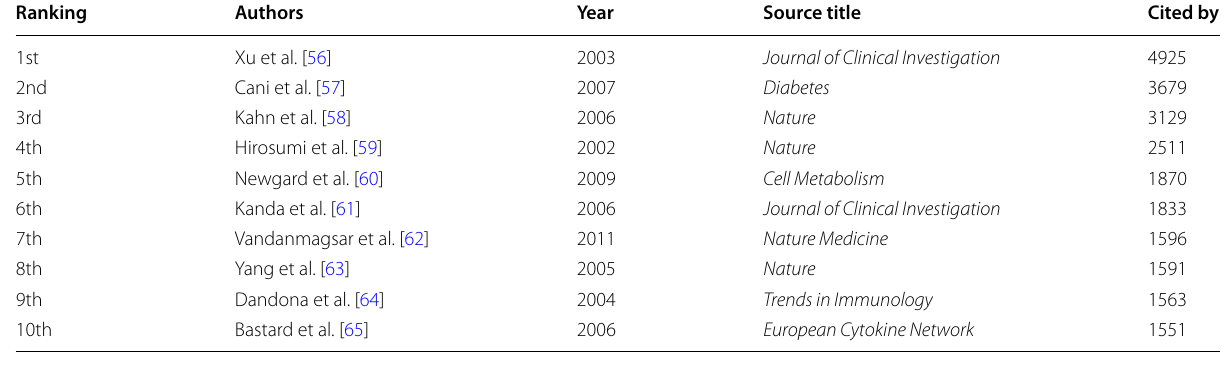
Table 4 A list of the ten most‑cited articles in insulin resistance and obesity based on the total number of citations, ranked in